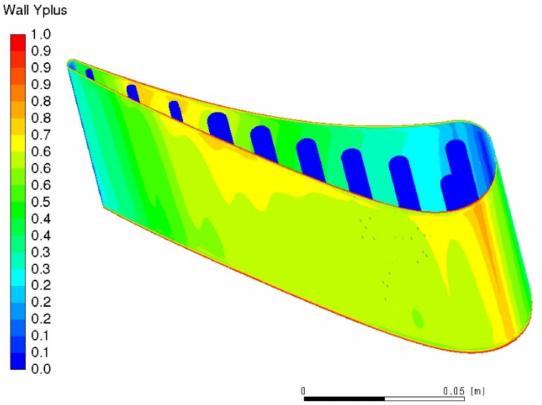
Figure 6. Y + meshing assessment factor